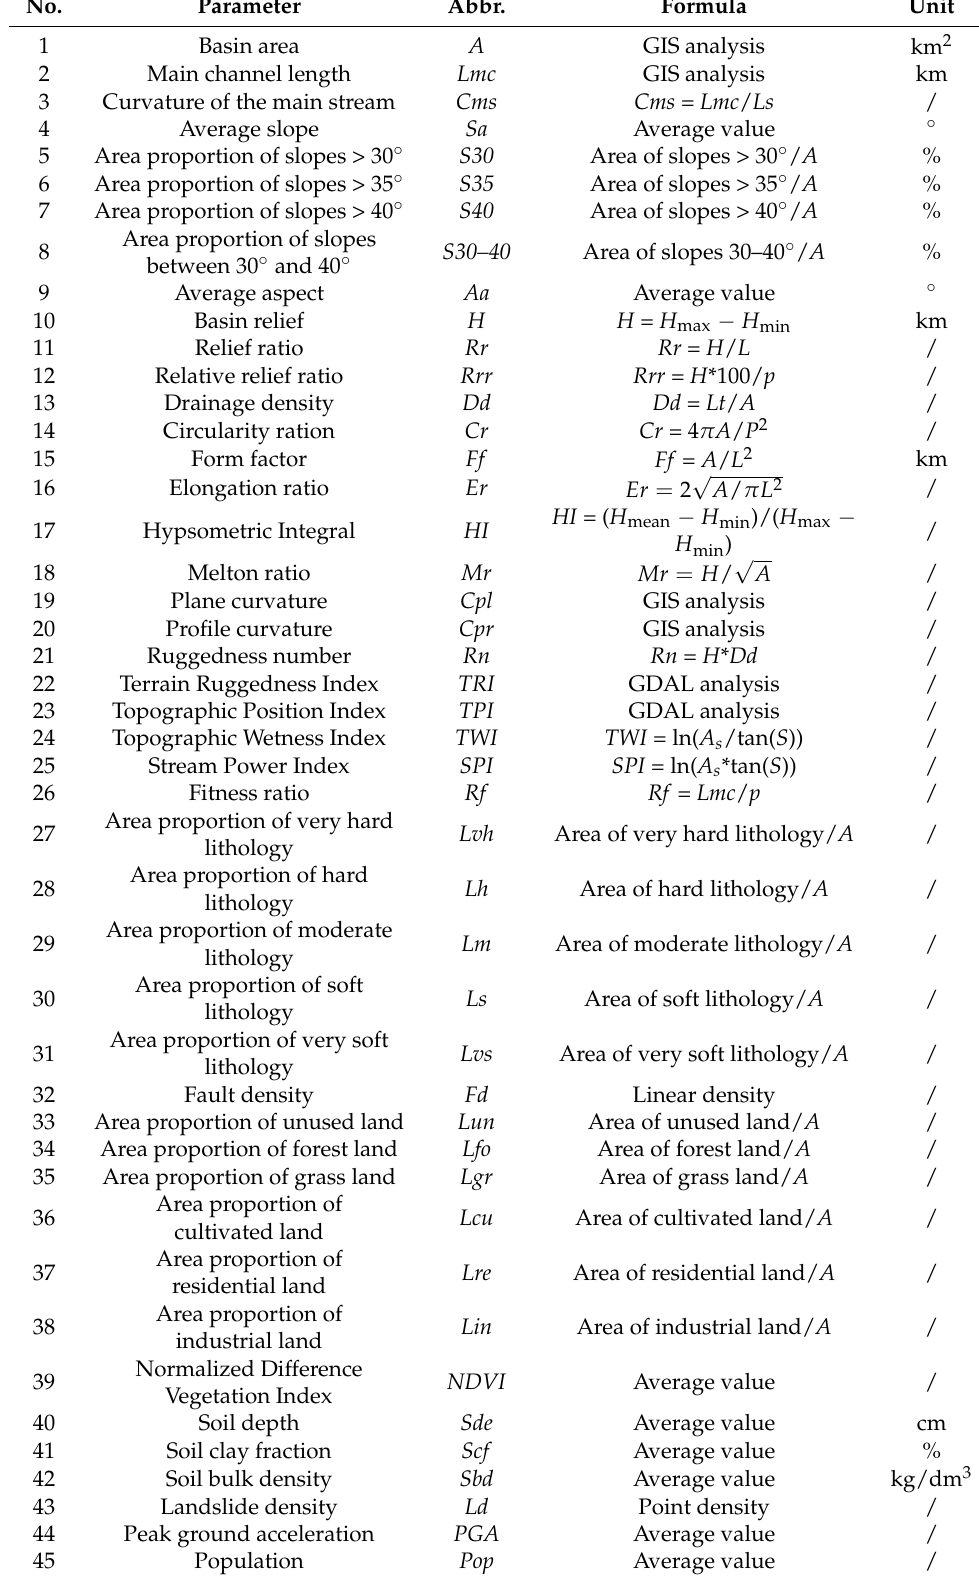
Table 2. Factors influencing debris flows. ( H max and H min are the maximum and minimum elevations in a catchment. Lt is the total length of stream channels. p is the basin